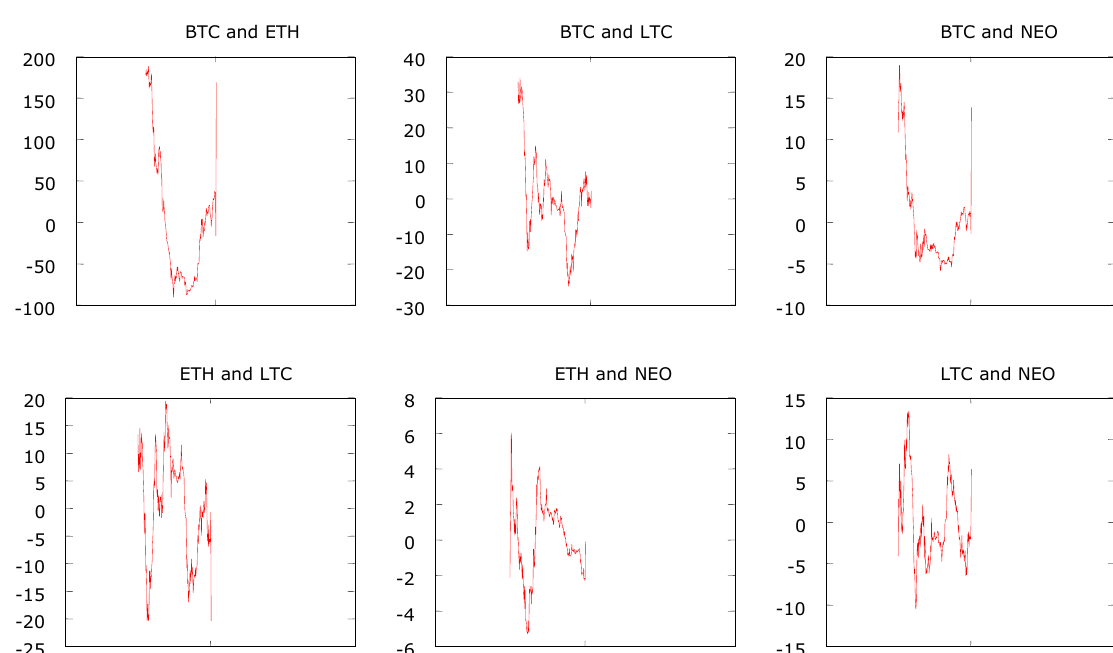
Figure 1. Cointegration residuals in Panel A